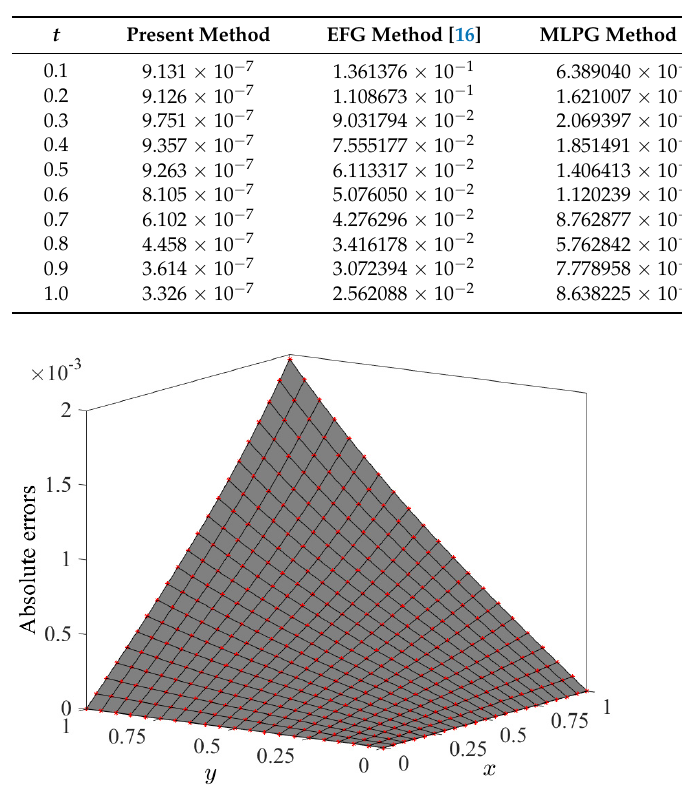
Table 2. Comparison between the present method and existing methods with h = 0.1 and ∆ t = 0.01 at different values of t for Example 1.